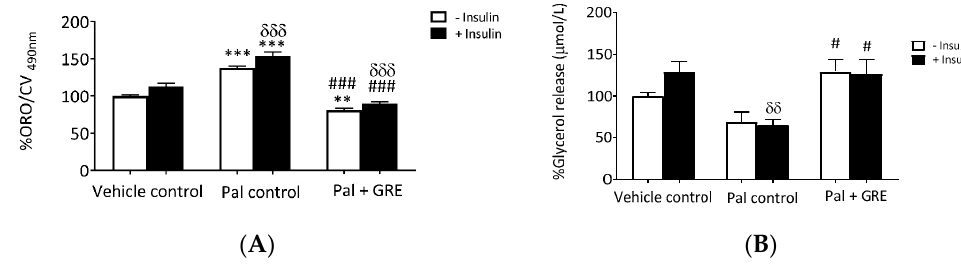
Figure 2. Effect of an aspalathin-enriched GRE on lipid accumulation ( A ) and glycerol release ( B ) in palmitate (Pal) treated C3A cells. Results are presented as mean ± SEM of three independent experiments. ** p < 0.01, *** p < 0.001 versus vehicle control (no insulin), # p < 0.001, ### p < 0.001 versus Pal control (no insulin). δδ p < 0.01, δδδ p < 0.001 versus insulin-stimulated vehicle control.